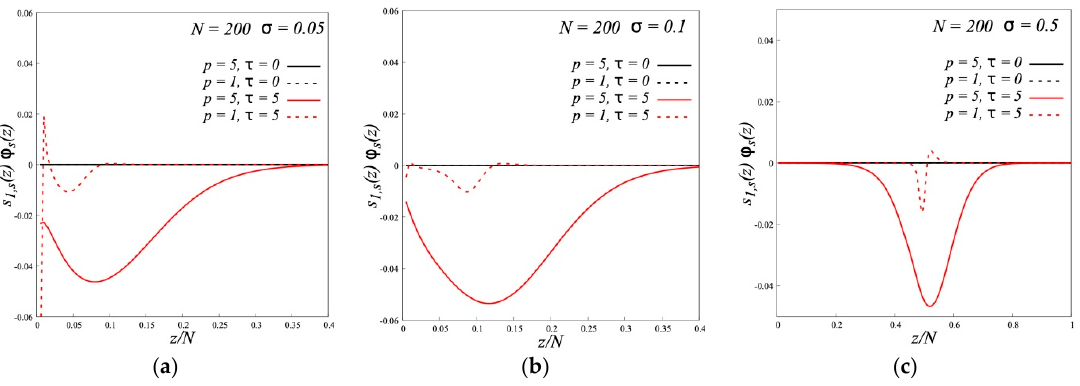
Figure 6. The segment orientation profile s 1, s ( z ) φ ( z ) = φ s ( z , + 1) − φ s ( z , − 1) of free polymer chains in melt with different stiffness ( p ) and different values of the parameter of dipole-dipole interactions ( τ ) at grafting densities σ = 0.05 ( a ), σ = 0.1 ( b ) and σ = 0.5 ( c ).